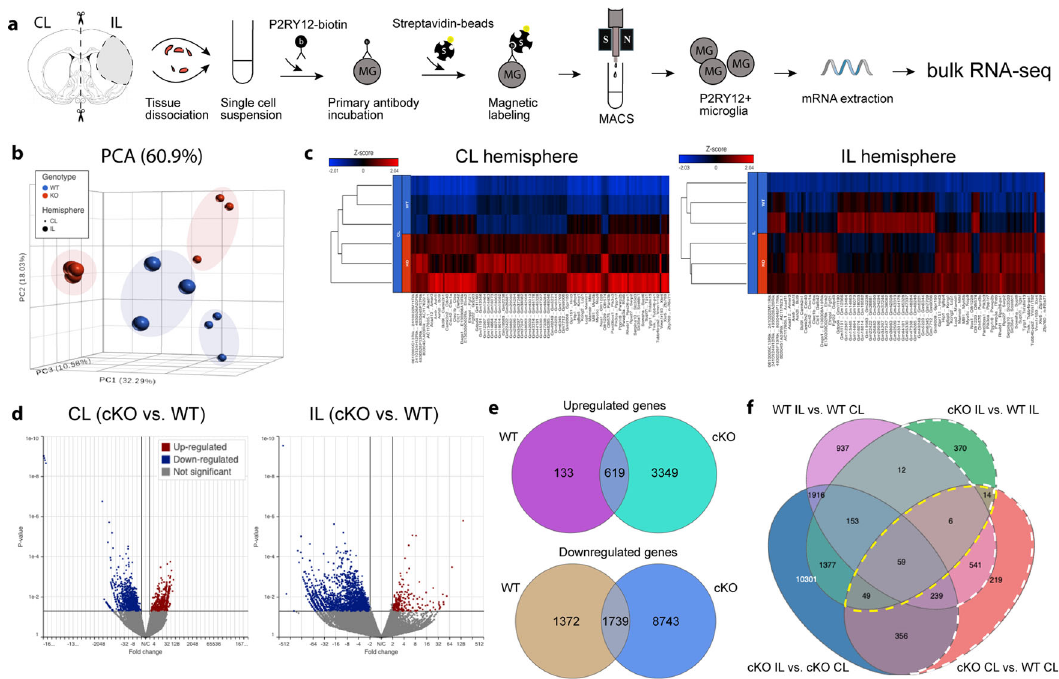
Fig. 2 Post-stroke differential transcriptomic changes of P2RY12 + microglia from WT and Nhe1 cKO mice. a Schematic illustration of P2RY12 + microglia isolation for bulk RNAseq on Illumina HiSeqX platform. b Principle component analysis plot showed separation of WT (blue) or cKO (red) data by their top three principal components. CL: small dots. IL: large dots. N = 3 biologically independent animals. c Heatmaps and unsupervised hierarchical clustering showing hemispheric microglial gene cluster changes. d Volcano plots of up- and downregulated genes. e Venn diagrams showing stroke-induced up- and downregulated genes in WT or cKO microglia (IL vs. CL). f Venn diagram with identi fi ed genes of interests for downstream pathway